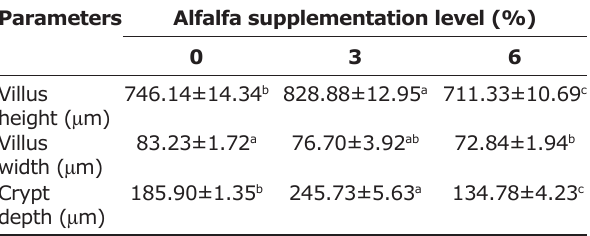
Table-3: The impact of alfalfa supplementation in the ration on the histomorphology of the duodenum of the hybrid